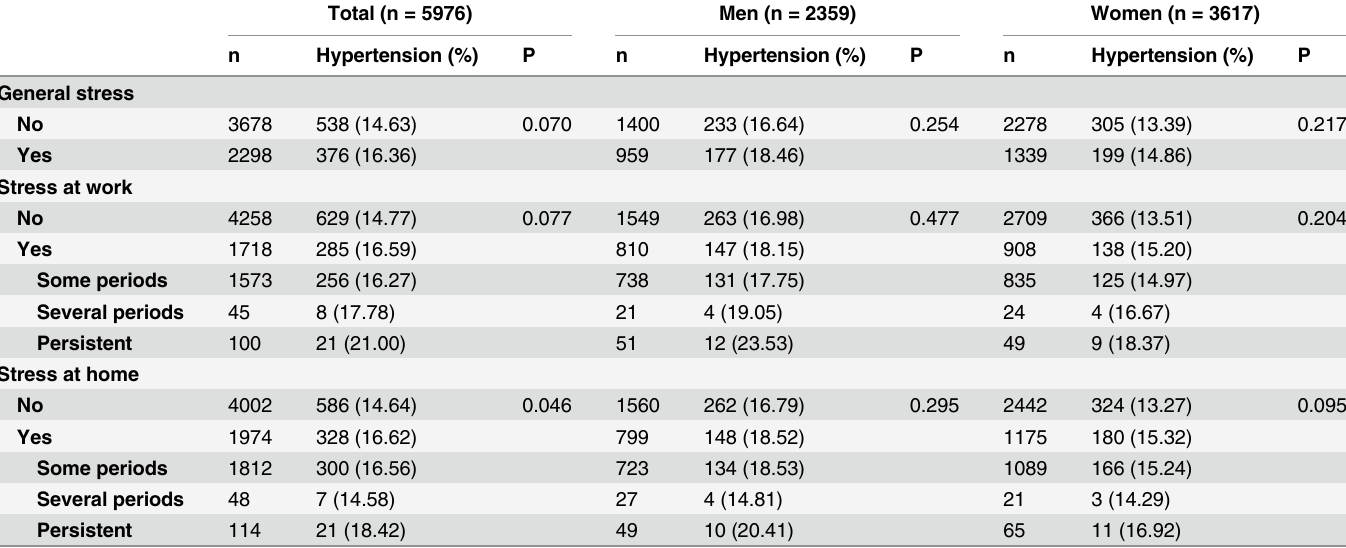
Table 2. The crude rates of hypertension for different types of stress by gender.